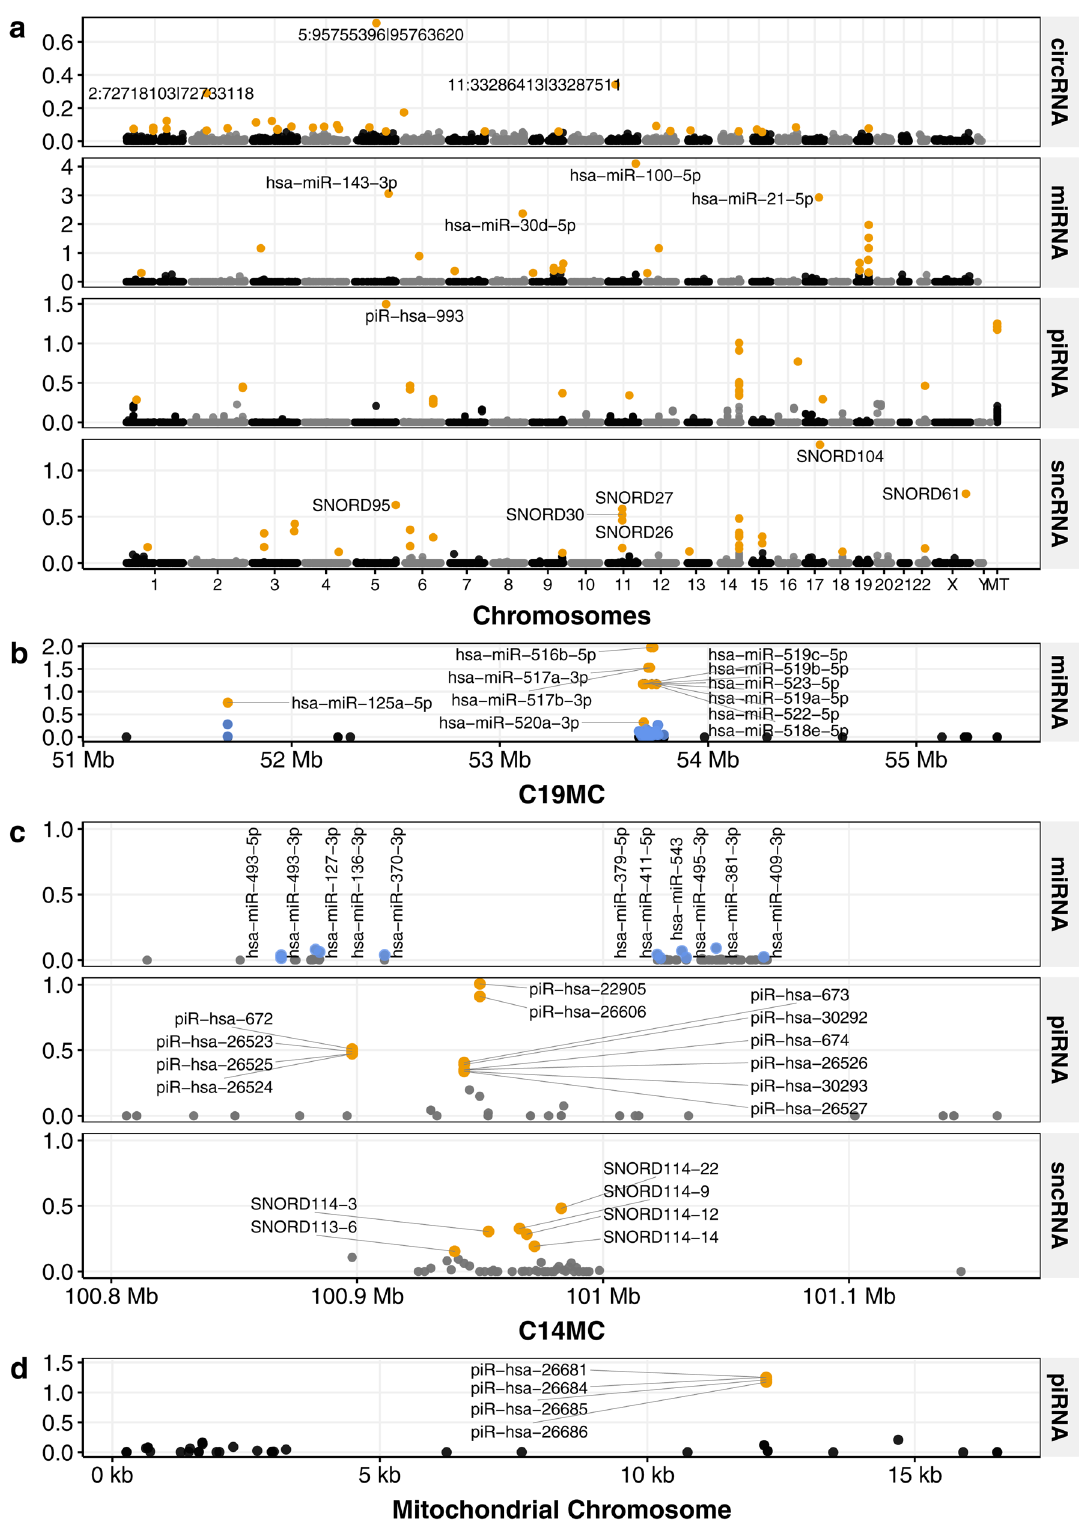
Fig. 2 Manhattan plots showing relative abundance of small RNAs. The relative abundance of individual transcripts, represented by dots, are shown for: a circRNAs, miRNAs, and piRNAs across all chromosomes; b clusters of miRNA on chromosome 19 (C19MC); c a cluster of miRNA, piRNA, and sncRNA on chromosome 14 (C14MC); d a mitochondrial cluster of piRNA. Transcripts within the most abundant 1% of circRNAs and miRNA, and within the most abundant 0.1% of piRNAs are colored orange. The relative abundance of piRNAs and miRNAs are calculated from the mean RPKM values divided by 10 6 . In the C19MC ( b ) and C14MC ( c ), miRNAs are colored blue if they are between the most abundant 1 and 5% range. The circRNAs are based on 3,279 circular RNAs predicted to be present in at least 30% of the cohort (POPS30) and their relative abundances are calculated from the normalized back-spliced read counts divided by 10 4 . See Supplementary Data 8, 11, 13, and 14 for abundance details of circRNAs, mature miRNAs, piRNAs, and sncRNAs, respectively.